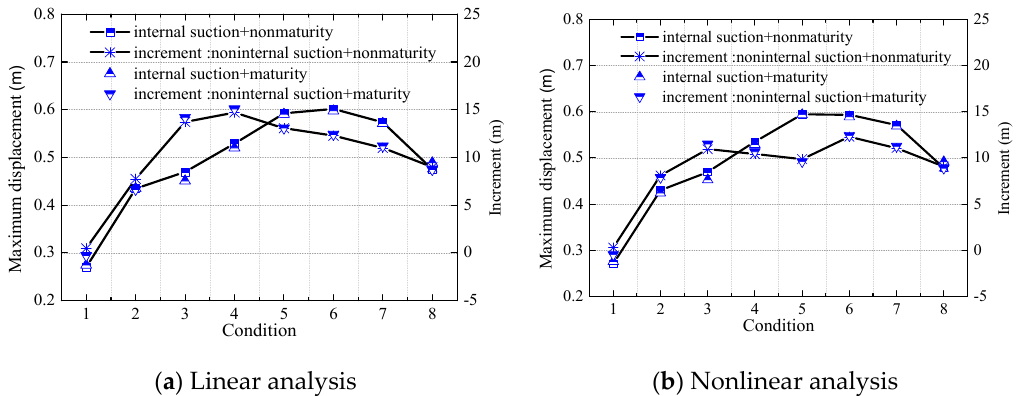
Figure 18. Comparison of maximum displacement in linear and non-linear analyses under critical buckling wind speed.